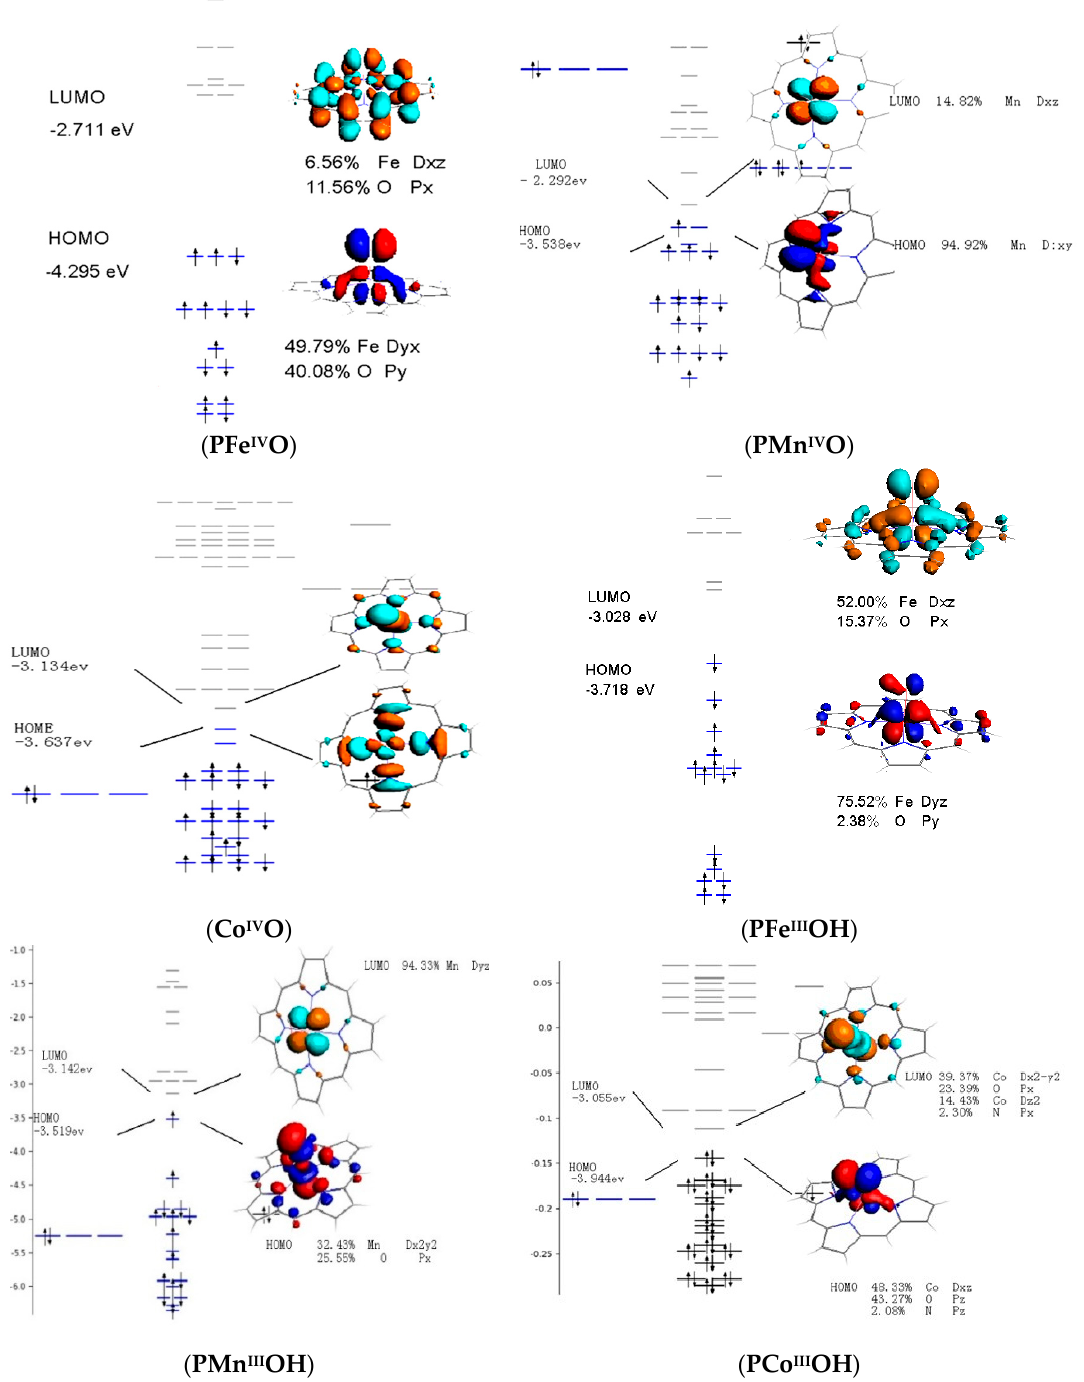
Figure 8. Frontier molecular orbitals of PM IV O and PM III OH (M=Fe, Mn, and Co).